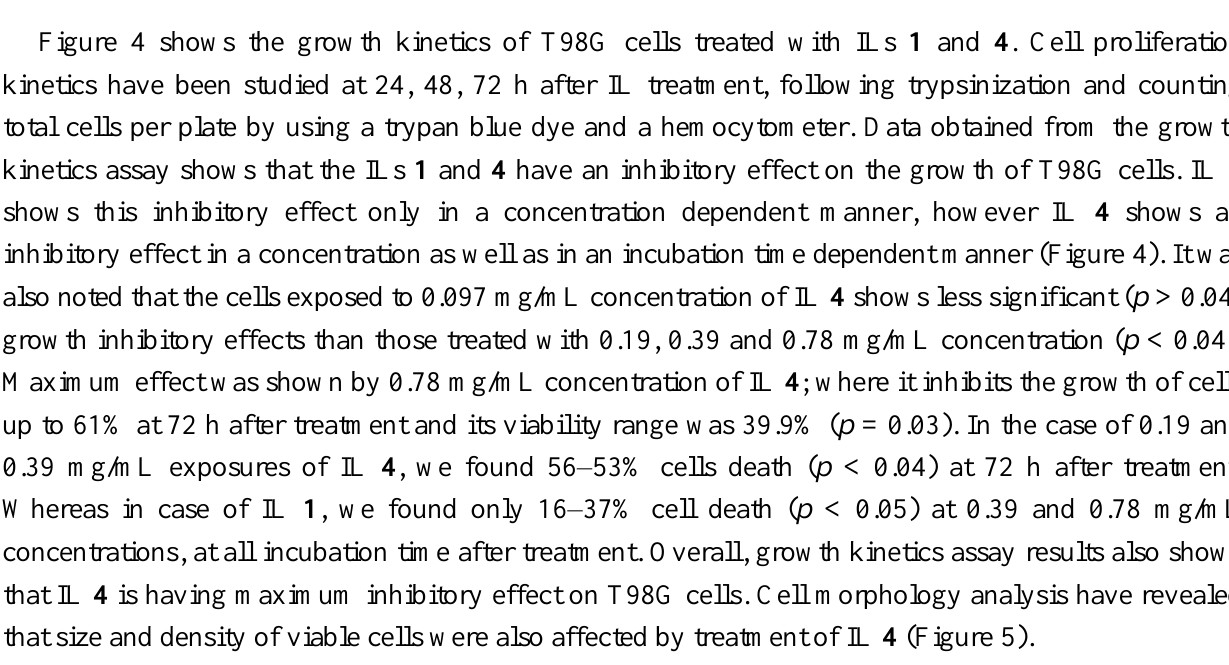
Figure 4. Growth kinetics of T98G cells at 24, 48 and 72 h after treatment by ILs at 0.097–0.78 mg/mL concentrations. Untreated cells are taken as control and all values given as mean (±SE) of three independent experiments, n = 3. All values are considered significant, when p <